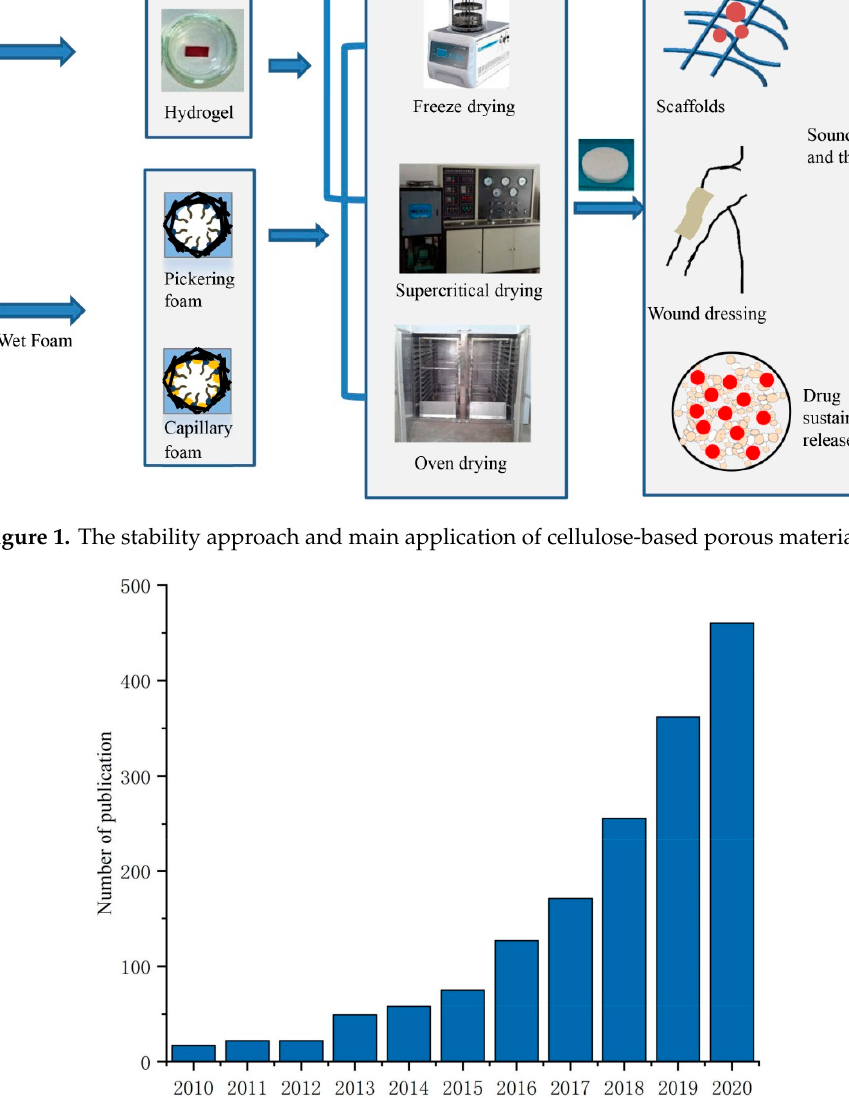
Figure 2. The annual amount of scientific publications obtained through Science Direct with the subject of “cellulose foam; cellulose